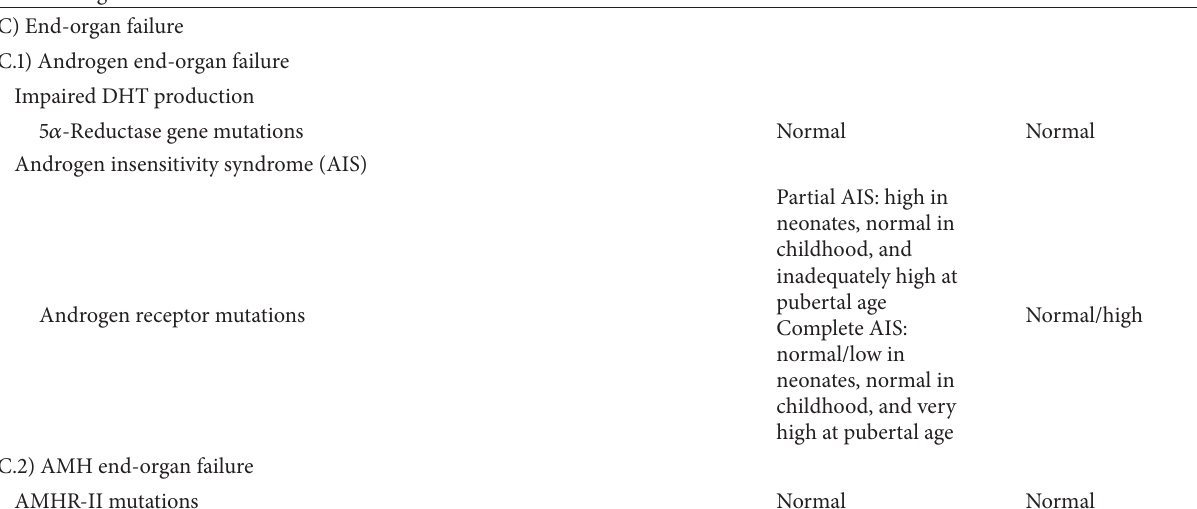
external genitalia Cloacal malformations, aphallia, and isolated hypospadias Normal